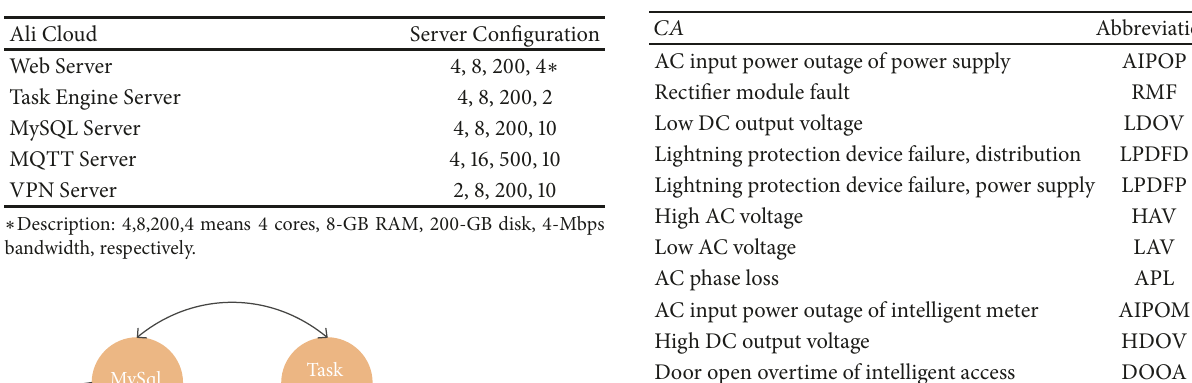
Table 4: Combined